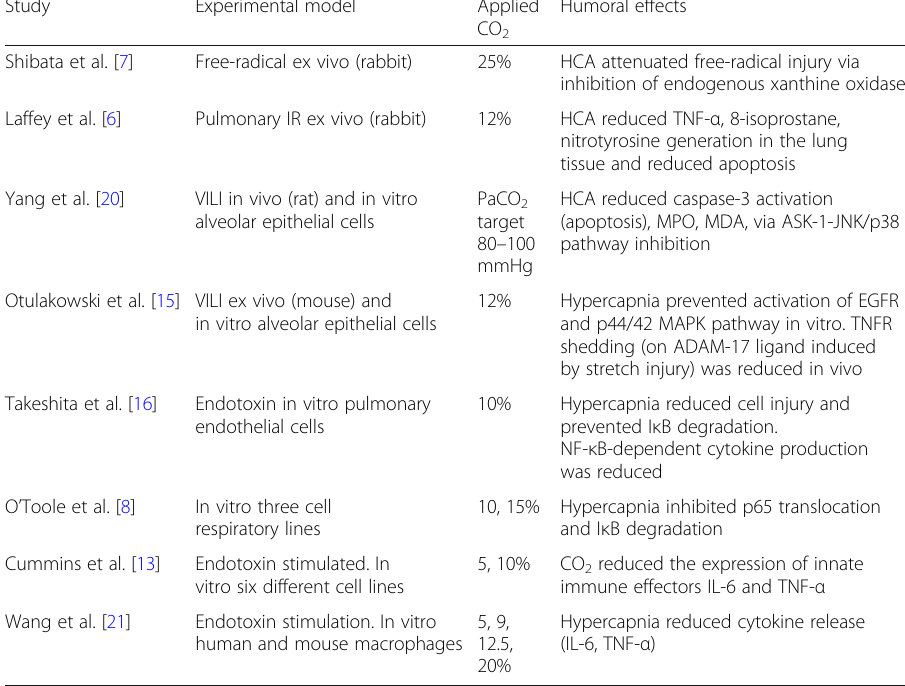
Table 2 Humoral effects of hypercapnia: summary of in vivo and ex vivo experiments on the effects of hypercapnia Study Experimental model Applied